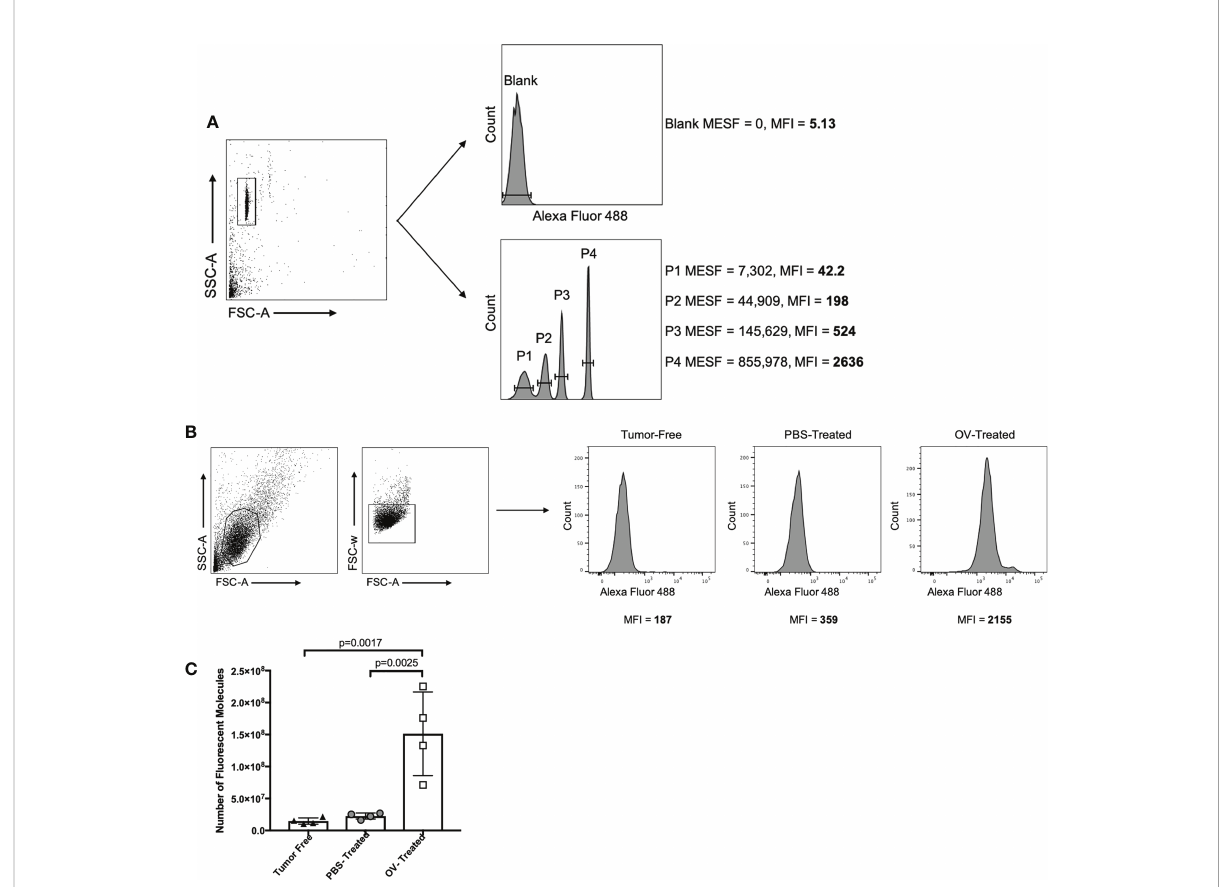
FIGURE 7 Strategy for standardizing fl uorescent output using Quantum TM molecules of equivalent soluble fl uorochrome (MESF; Bang Laboratories). (A) Quantum TM Alexa Fluor 488-conjugated beads were isolated based on forward scatter area (FSC-A) versus side scatter area (SSC-A) characteristics, and the mean fl uorescence intensity (MFI) of each bead population containing a de fi ned number of molecules of MESF was determined by fl ow cytometry. (B) In the same experiment, target oncolytic virus (OV)-infected Vero cells were identi fi ed by graphing FSC-A versus SSC-A, and doublets were excluded by graphing FSC-A versus forward scatter width (FSC-W). The MFI of the anti-mouse IgG1-Alexa Fluor 488 signal was then determined for target cells treated with a 1/250 dilution of plasma from tumor-free, phosphate-buffered saline (PBS)-treated tumor-bearing or OV-treated tumor-bearing mice. Virus- associated antibody binding was represented as histograms with cell counts on the y-axis and the intensity of the secondary Alexa Fluor 488-conjugated mouse IgG1-speci fi c antibody signal on the x-axis. (C) The MFI of each Quantum TM bead population was plotted against the de fi ned MESF number to generate a standard curve. The MFI of anti-mouse IgG1 Alexa Fluor 488 from targeted OV-infected Vero cells treated with plasma from different treatment groups was plotted against the standard curve to estimate the number of anti-mouse IgG1-Alexa Fluor 488 molecules bound, which was then multiplied by the 1/250 dilution factor to approximate the number of virus-associated antibodies present in the original plasma